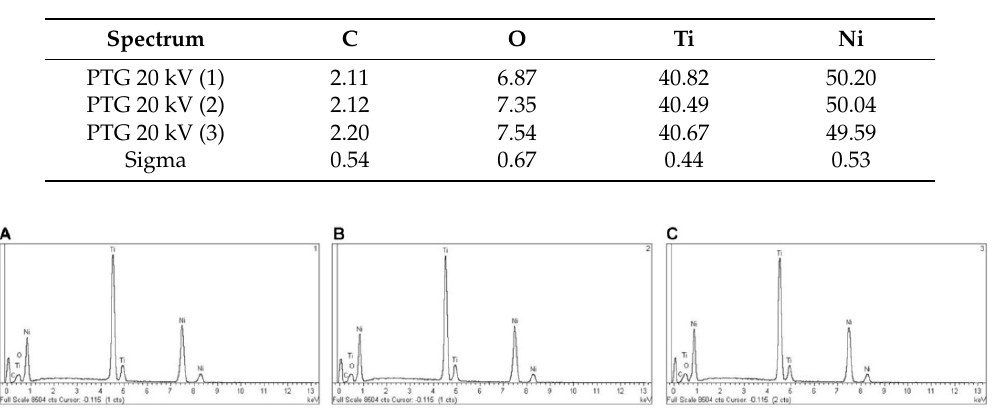
Figure 12. EDX micro-analysis of CM-Gold Wire PTG endodontic rotary files in location ( A ) 1, ( B ) 2, and ( C ) 3.